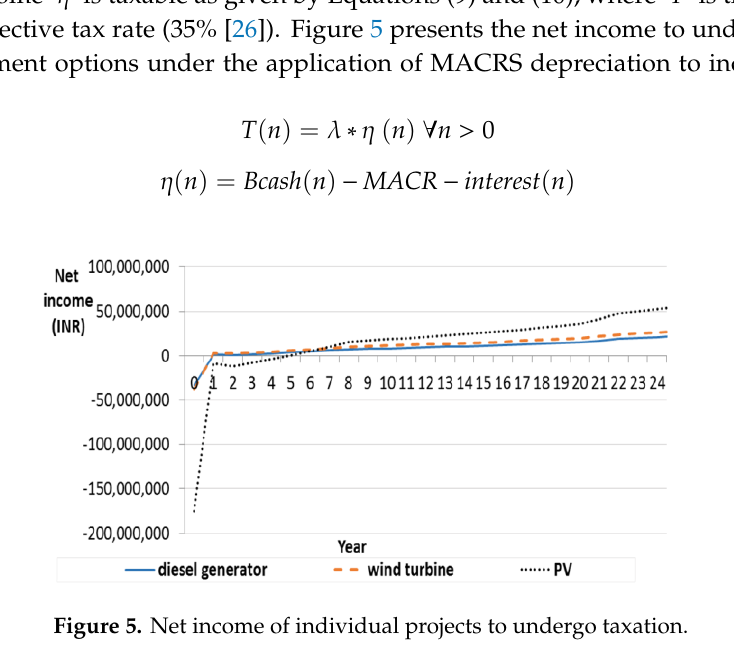
Figure 6. Incremental IRR analysis execution.